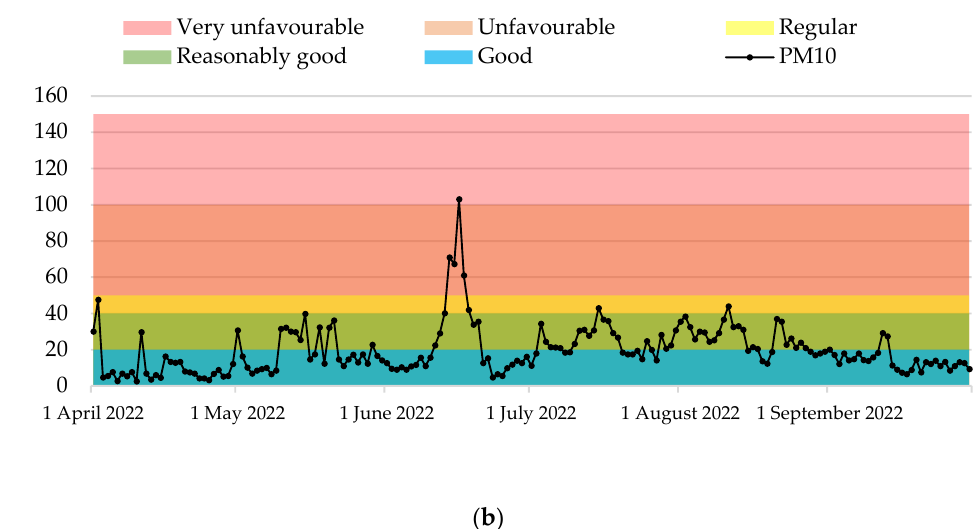
Figure 7. ( a ) Air quality assessment for pollutant O 3 ; ( b ) and PM10.